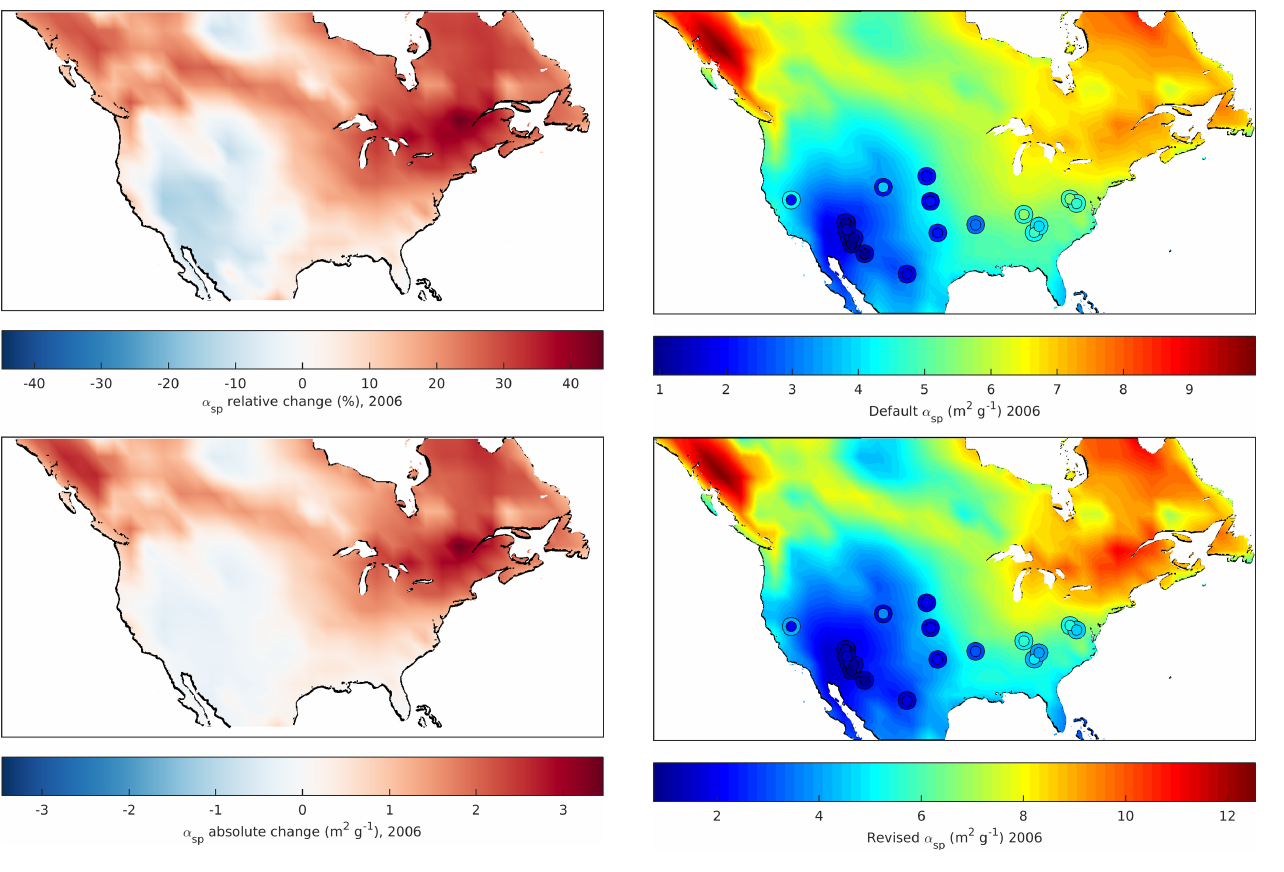
Figure 11. GEOS-Chem annual average mass scattering efficiency (at 550nm) for the year 2006 using default and revised sizes and hygroscopicity for secondary inorganic and organic aerosols. Over- laying inner circles represent annual averages of α sp at IMPROVE network sites for the year 2006. Outer rings represent coincident average simulated α sp